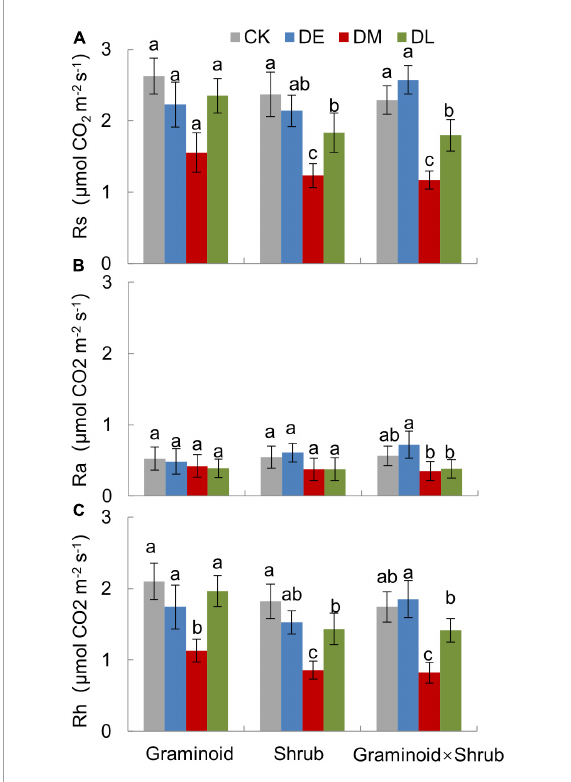
FIGURE2 Growing season mean value of total soil respiration (Rs, A ), autotrophic respiration (Ra, B ), and heterotrophic respiration (Rh, C ) under different drought timing treatments in three PFTs in 2017. Data are mean ± 1SE. Different letters indicate significant differences ( P ≤ 0.05) among treatments.